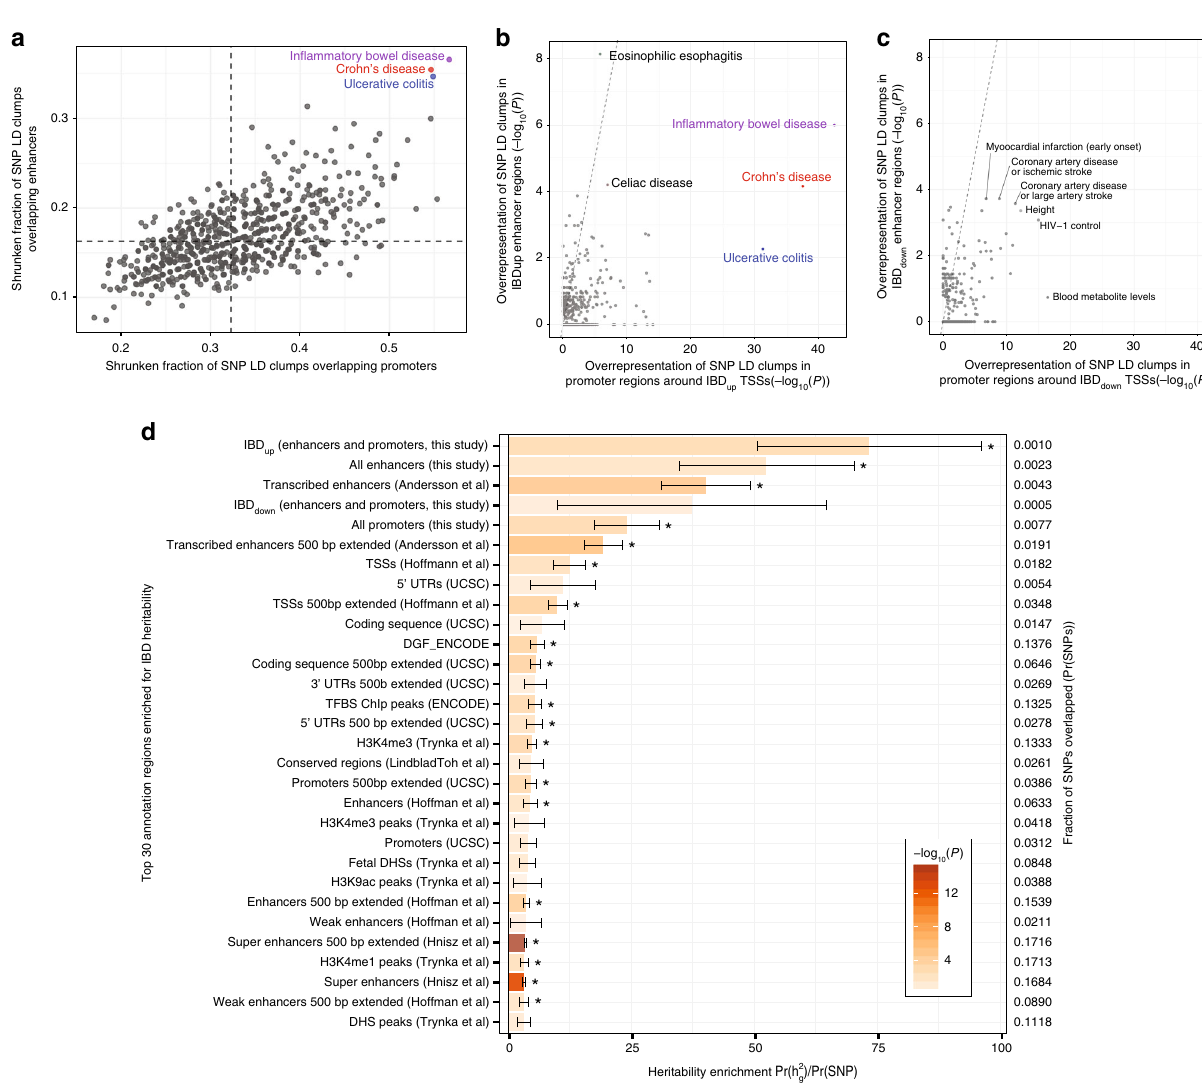
Fig. 6 Relation between IBD-associated SNPS and IBD-induced regulatory regions. a Overlap of GWAS catalog diseases and traits with identi fi ed TSSs and enhancers. Y -axis shows the fraction of SNP LD-clumps associated to each GWAS catalog disease/trait that overlaps enhancer regions identi fi ed in this study. X -axis shows the same statistic for promoter regions, de fi ned from CAGE TSSs identi fi ed in this study. Fractions are shrunk towards the mean across all diseases/traits (dashed lines) using empirical Bayes. LD clumps associated to CD, UC, and IBD show the highest degree of overlap with both promoter and enhancer sets. b Enrichment of IBD up promoters and enhancers for GWAS catalog diseases/traits. Y -axis shows the overrepresentation of LD-clumps linked to GWAS catalog diseases/traits in IBD up enhancers vs. all enhancers expressed as Fisher ’ s Exact test P values. X -axis shows the same statistic for promoter regions corresponding to IBD up TSS vs. all TSSs. Each dot represents one GWAS catalog disease/trait. UC, CD, and IBD are the only shared enrichments between the two sets. c Enrichment of GWAS catalog diseases and traits for IBD down promoters and enhancers. Plot is organized as in b , but showing LD-clump enrichment of IBD down enhancers ( Y -axis) and promoters corresponding to IBD down TSSs ( X -axis). d Partitioned heritability of IBD for different classes of genomic regions. Bar plots show the heritability enrichment of IBD, as estimated by strati fi ed LD-score regression for each category, (cid:1) (cid:3) = Pr SNPs ð Þ in the respective regions 40 . Whiskers show jackknife standard errors of the heritability enrichment. Y- axis shows the top expressed as Pr h 2 g enriched genome regions, de fi ned in ref. 40 , supplemented by regions de fi ned in this study as indicated, sorted by enrichment score. Bar color indicates signi fi cance of enrichment in log 10 scale; asterisks indicate FDR < 0.05. Percentages to the right indicate the fraction of the genome covered by each set of regions Pr SNPs ð Þð Þ